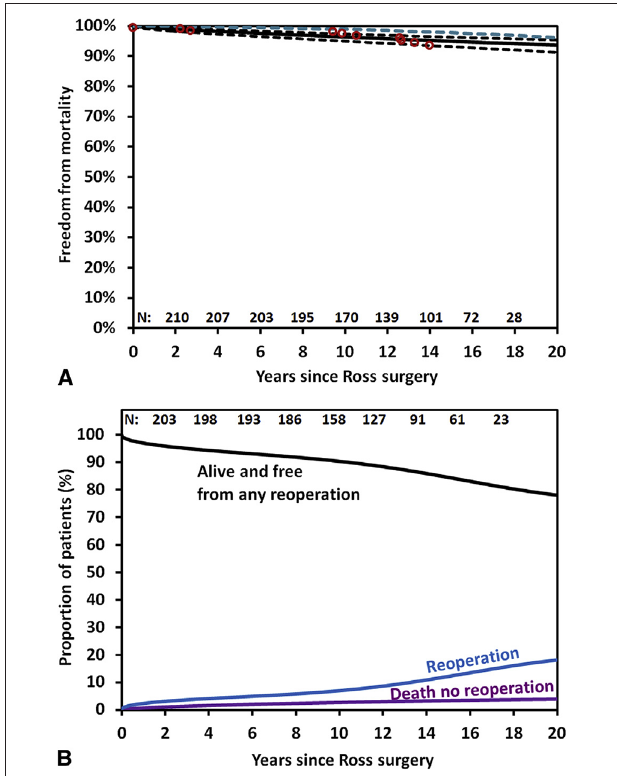
FiguRe 2 | (A) Survival estimates of patients who underwent the Ross procedure, including those who no longer had the pulmonary autograft ( black solid line ) with 95% confidence limits ( black dotted line ) and that of the general population matched for age and sex ( dotted blue line ). (B) Reoperation-free survival and the competing risks for any reoperation on the pulmonary autograft or homograft and death (David et al.) (pernited with permission from JTCVS)